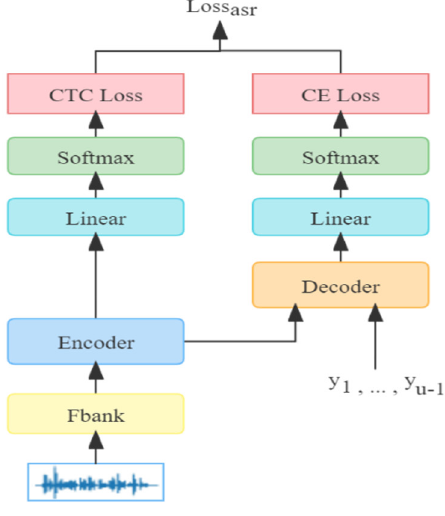
Figure 1. The framework of the ASR system.